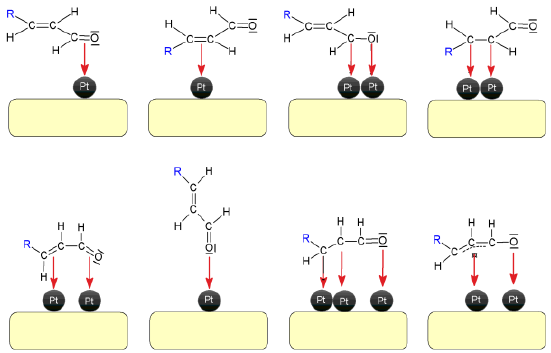
Figure 3. Adsorption modes of the α,β-unsaturated aldehyde molecule. Adapted from